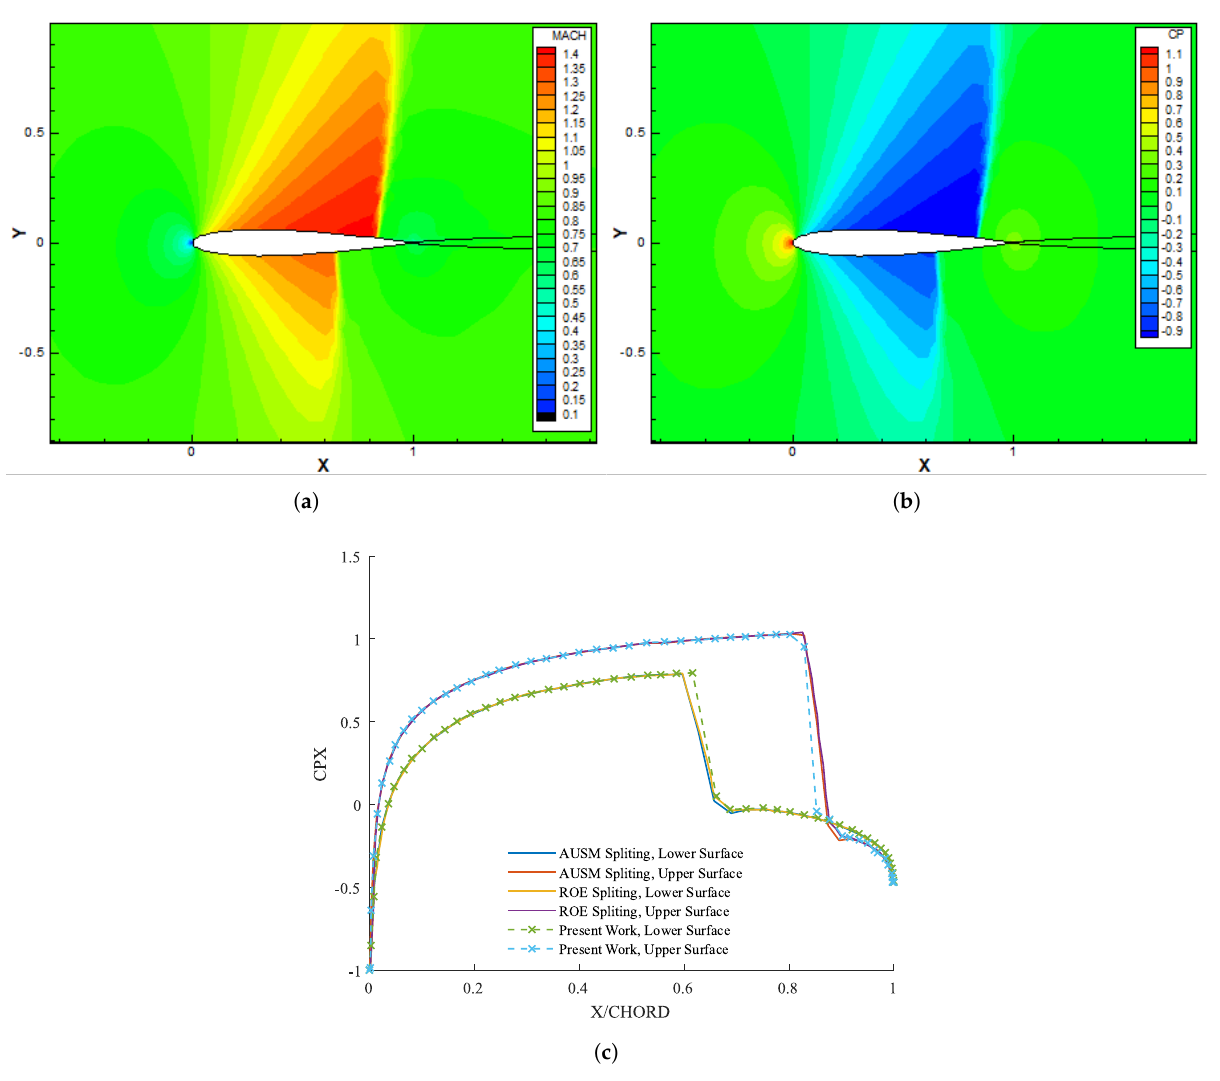
Figure 2. ( a ) The Mach lines around the NACA 0012 airfoil under nonlinear flow conditions at M = 0.8 and α = 1 ◦ are presented. ( b ) Nonlinear pressure coefficient lines are shown around the same airfoil under the same flow conditions. ( c ) The pressure distribution on the surface of the NACA 0012 airfoil is presented for non-viscous flow at M = 0.8 and α = 1 ◦ , and the results are compared to the numerical results obtained by Liou and Steffen Jr.